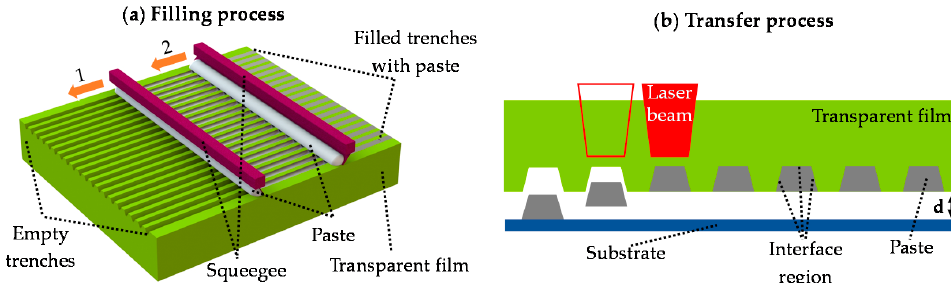
Figure 1. Illustration of the printing sequence of Pattern Transfer Printing (PTP): ( a ) filling process; ( b ) transfer process. Reprinted, with permission, from ref [8]. © [2020] IEEE. The paste transfer process of PTP gradually changes with increasing laser